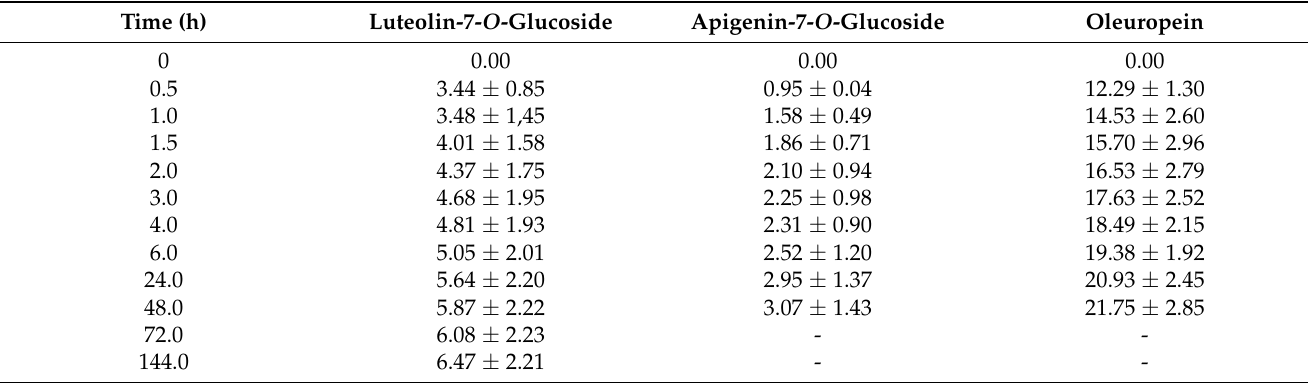
Figure 6. Graph showing the cumulative release (Release %) of polyphenols from PHBHV/OLE fiber meshes up to 144 h. Table 3. Cumulative release (µg) of the main OLE phenolic compounds in a 4 cm 2 square of PHBHV/OLE fiber mesh. Data are expressed as means ± SD ( n = 2).